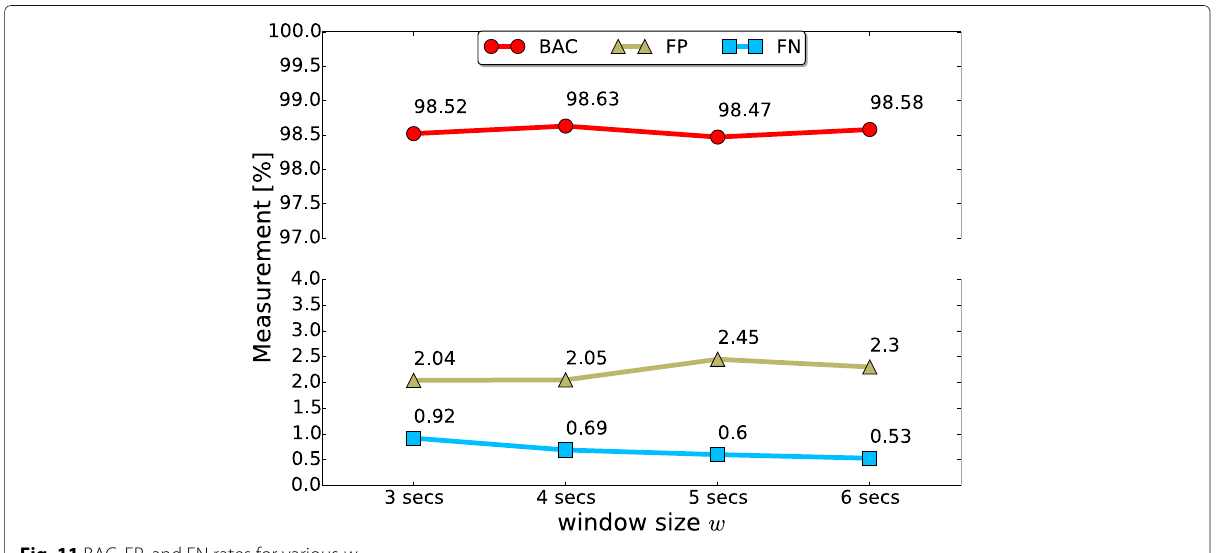
Fig. 11 BAC, FP, and FN rates for various